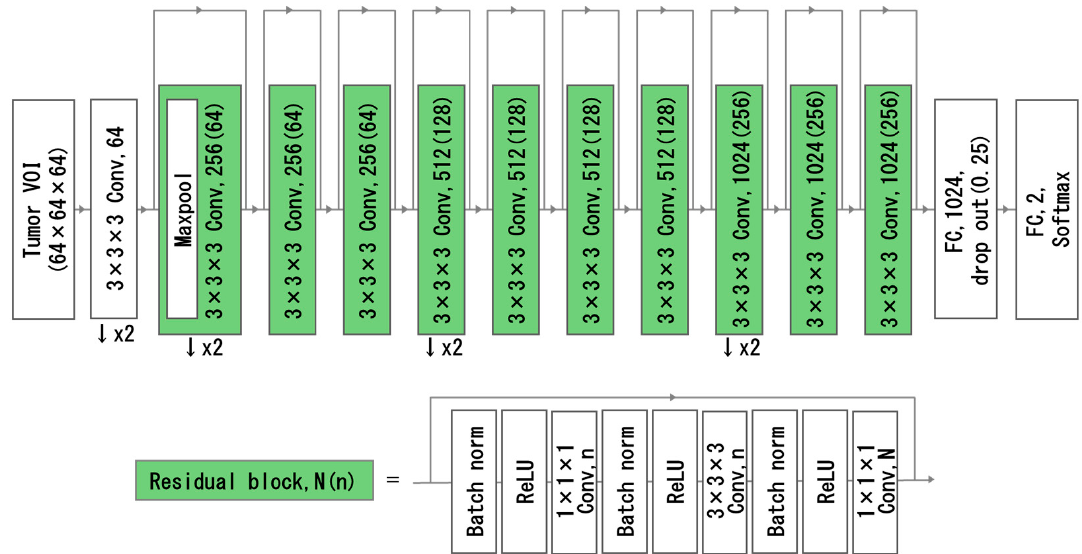
Figure 3. 3D CNN architecture used for grading. This model is extension of ResNet, and it was designed and trained by us.